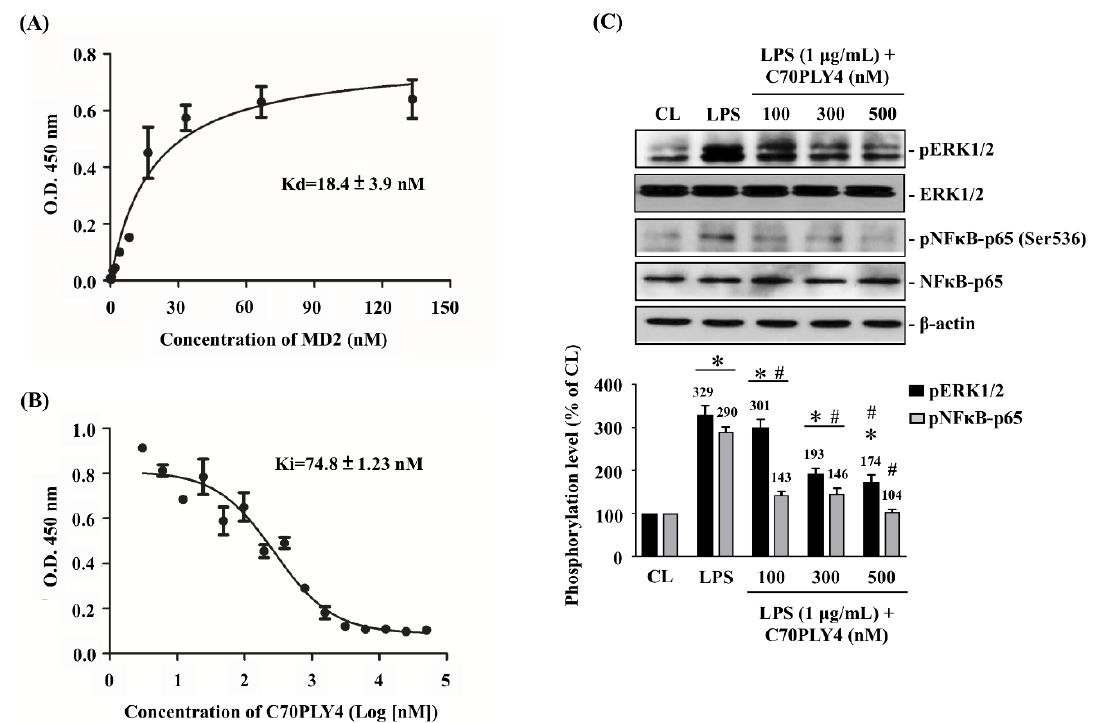
Figure 3. C70PLY4 competes with MD2 for the binding site on TLR4 in vitro and inhibits LPS-induced ERK1 / 2 and NF- κ B phosphorylation in HUVECs. ( A ) TLR4 (2 µ g / mL) was coated onto a 96-well plate. MD2 was added to the wells at various concentrations (2-fold serial dilutions from 133.3 to 0.065 nM), and the Kd value was determined. ( B ) TLR4 (2 µ g / mL) was coated onto a 96-well plate. Mixtures of MD2 (50 nM) and various concentrations (2-fold serial dilutions from 50 µ M to 3.05 nM) of C70PLY4 were added to the wells, and the Ki value was determined. ( C ) The HUVECs were kept untreated as a control, treated with LPS (1 µ g / mL) alone for 24 h, or co-treated with LPS (1 µ g / mL) and C70PLY4 (100, 300, and 500 nM) for 24 h, and the protein phosphorylation of the ERK1 / 2 and NF κ B-p65 subunit were examined. The results ( C , upper panel) are representative of three independent experiments with similar results. The data for ( A ), ( B ) and ( C , down panel) are the mean ± SEM from at least three independent experiments. *, p < 0.05 vs. control cells. #, p < 0.05 vs. LPS-only-treated cells.